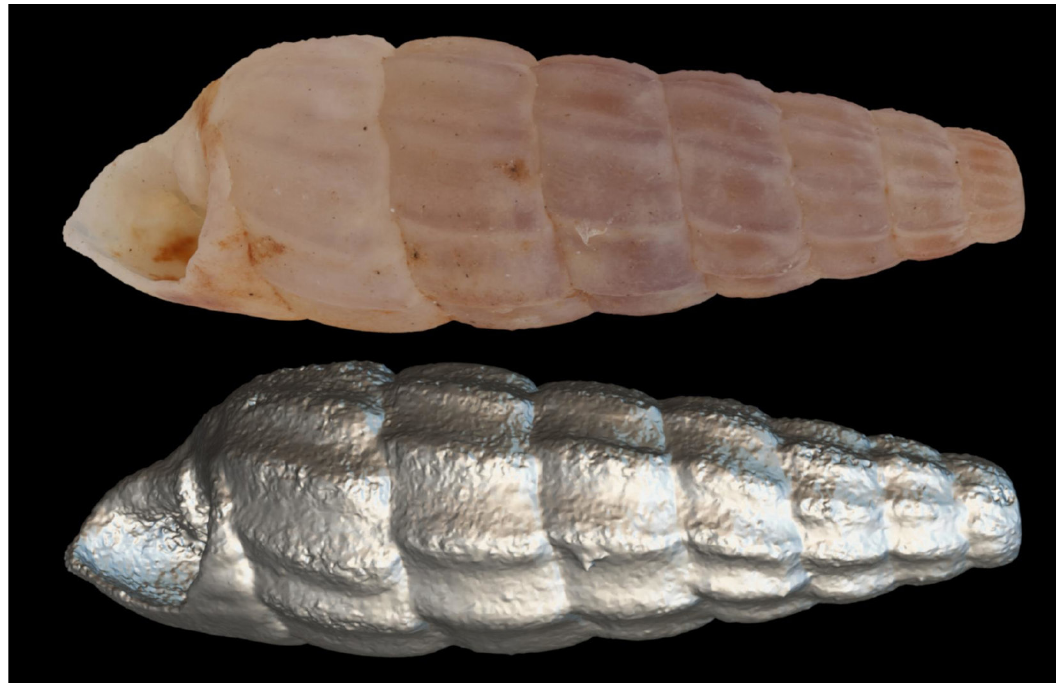
Figu. 3.18. 3D model (top image with texture; bottom image with mesh only), of the mollusk Anceya giraudi generated in Agisoft Photoscan based on focus-stacked images. The size of the shell is 9 mm.